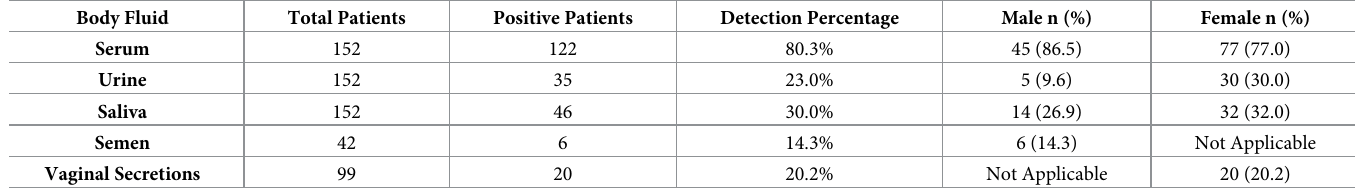
Table 3. Detection of CHIKV RNA in Body Fluids, According to Gender for 152 enrolled participants � . Body